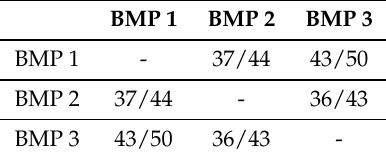
Table 19. Test results for similar BMP images with LZJD (signature comparison/file comparison).